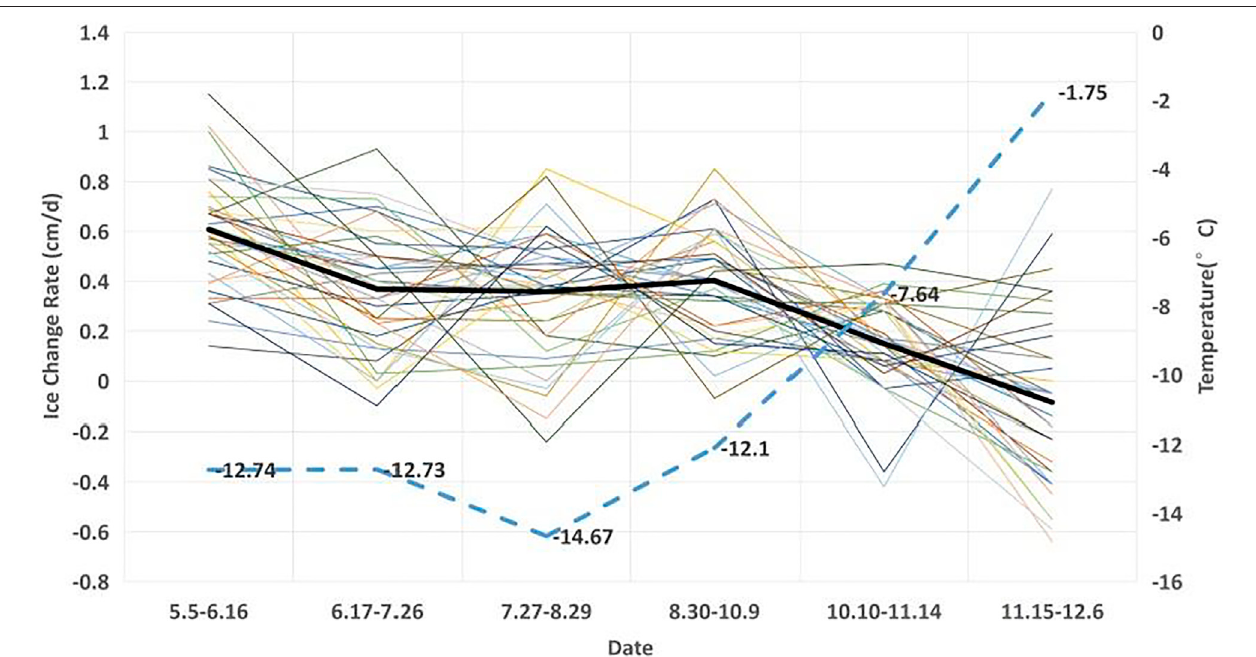
FIGURE6| Relationshipbetweenairtemperatureandseaicegrowthrate.(Blacksolidline:overalltrendofseaicethicknessgrowthrate;bluedottedline:thetrend of mean temperature over the study period; colored dotted line: variation trend line of sea ice growth rate at 38 observation points).